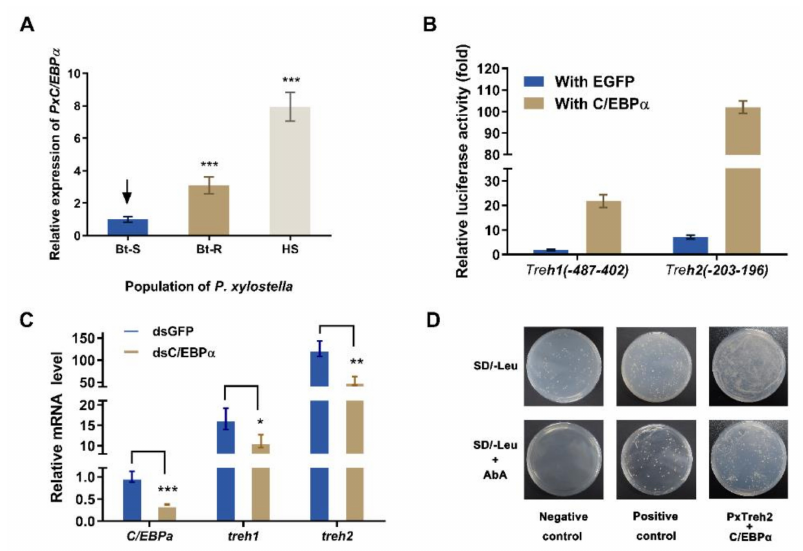
Figure 5. Effect of C/EBP α on the expression of PxTreh genes in vivo. ( A ) The expression of PxC/EBP α in the fourth-instar larvae of the Bt-S, Bt-R, and HS Plutella xylostella . The EF1 gene was used as an internal control. ( B ) Effects of C/EBP α on the activity of PxTreh 1 and PxTreh 2 promoters. The empty pEGFP-N1 vector that overexpressed green fluorescent protein (EGFP) was used as the control. ( C ) The relative expression of PxC/EBP α in larvae of the sensitive strain at 24 h post-injection with C/EBP α , dsGFP, or dsC/EBP α . The EF1 gene was used as the internal control. ( D ) The effect